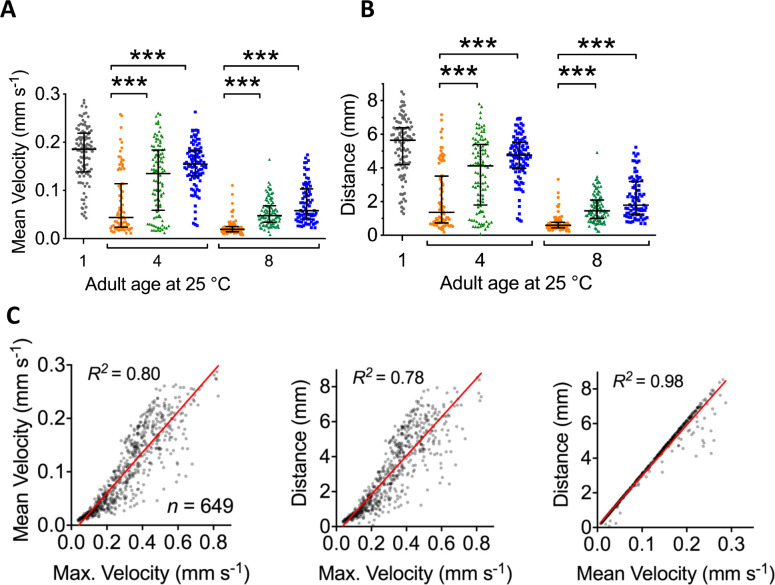
Movement analysis.Movement parameters measured included maximum velocity (shown in Figure 6E), mean velocity and total distance travelled. The latter two datasets are represented in Figure 6-figure supplement A and B. Pooling all groups and ages reveals that all movement parameters (maximum velocity, mean velocity and distance travelled in 30 s) are all positively correlated, as shown in (C). (A) Estimates of mean velocity (mm s−1) achieved by aged and treated cohorts of C. elegans. (Grey = starting population, red = control, green = Lip-1-treated, blue = SIH-treated) Treatment with either Lip-1 or SIH attenuates the age-related decline in mean velocity (Kruskal-Wallis ANOVA: H(7) = 339.2, p<0.0001), see Supplementary file 6 for summary data and pair-wise comparisons). (B) Estimates of total distance travelled (in 30 s) by aged and treated cohorts of C. elegans. (Grey = starting population, red = control, green = Lip-1-treated, blue = SIH-treated) Treatment with either Lip-1 or SIH attenuates the age-related decline in distance travelled (Kruskal-Wallis ANOVA: H(7) = 340.6, p<0.0001)see Supplementary file 6 for summary data and pair-wise comparisons). C: Correlation of estimated movement parameters.